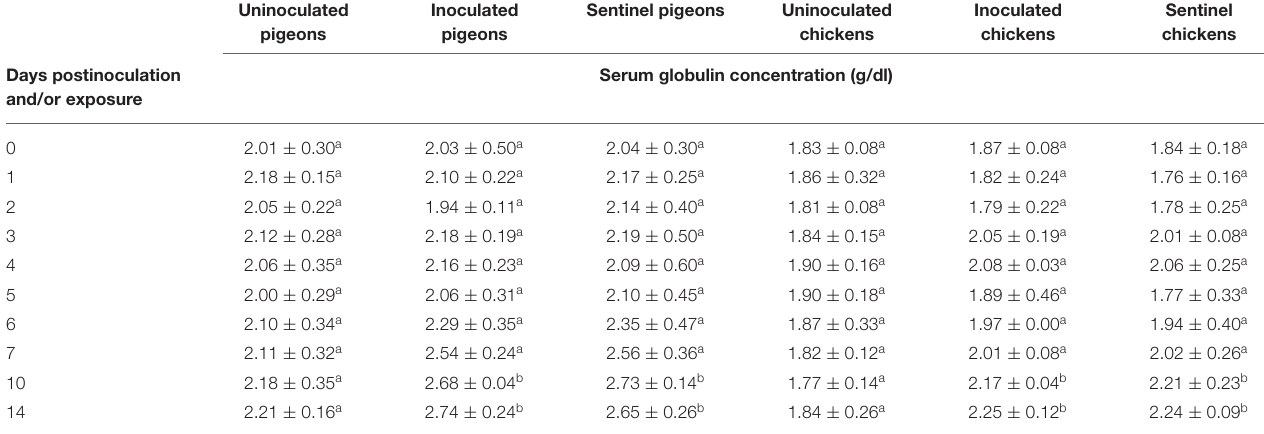
TABLE 9 | Mean serum globulin concentration of pigeons and chickens following inoculation with and/or exposure to a very virulent infectious bursal disease virus.